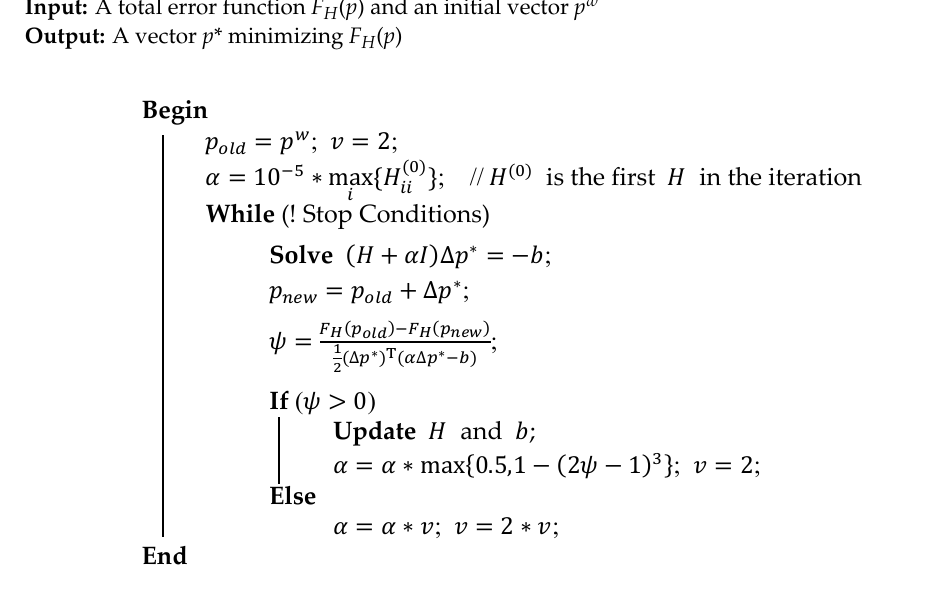
Algorithm 1: Pseudo code of LM algorithm